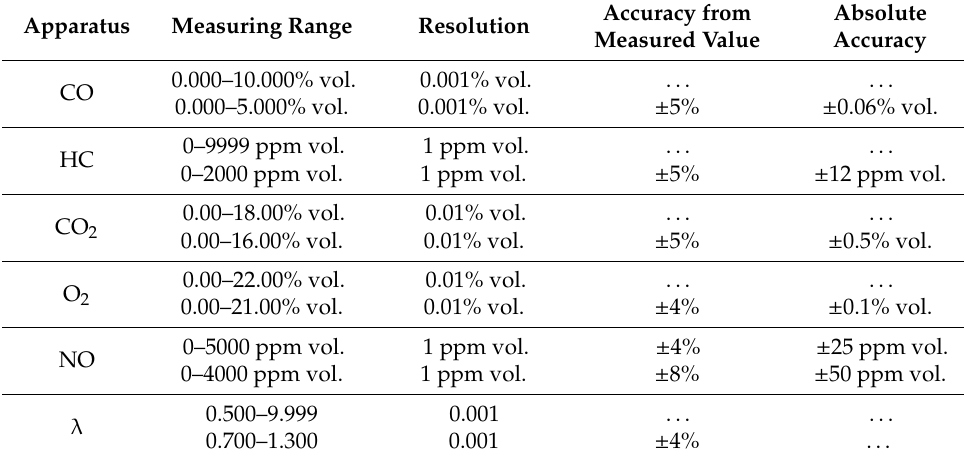
Table 2. Parameters of the Bosch BEA 350 analyzer